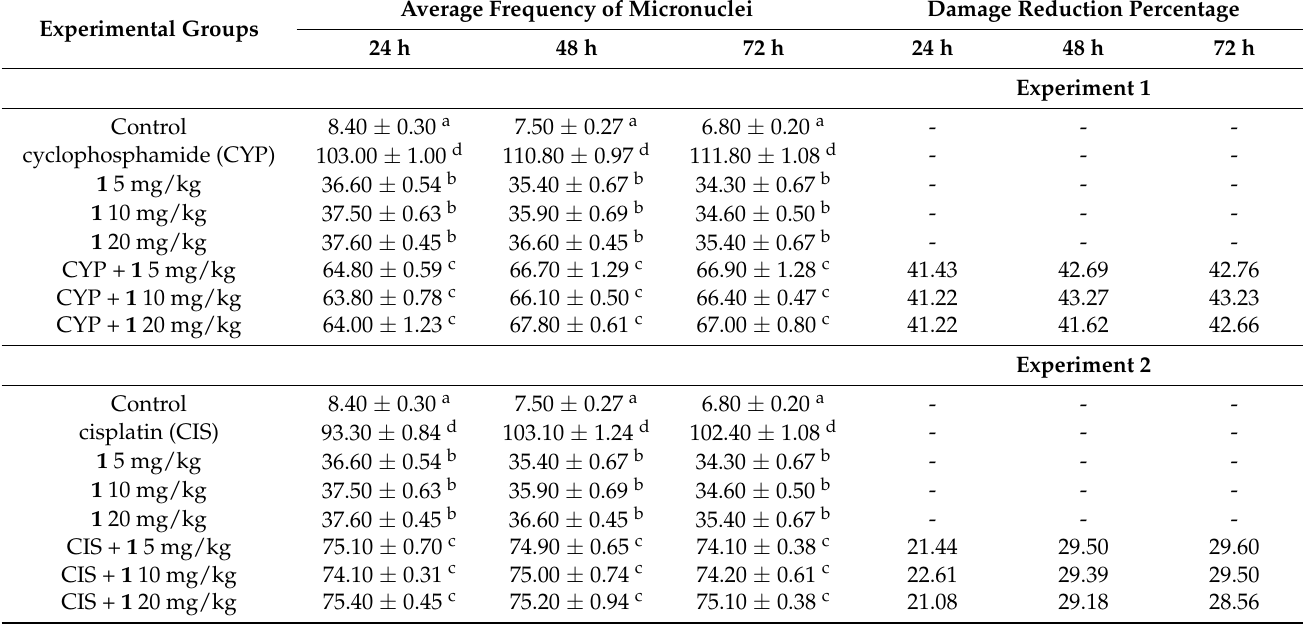
Table 3. Mean frequency ± Standard error of mean and percentage of damage reduction referring to micronucleus assays in peripheral blood of Swiss mice